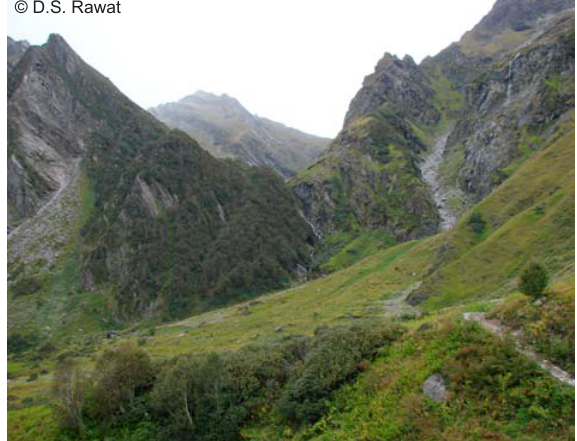
Image 1. A view in Valley of Flowers National Park showing collection area